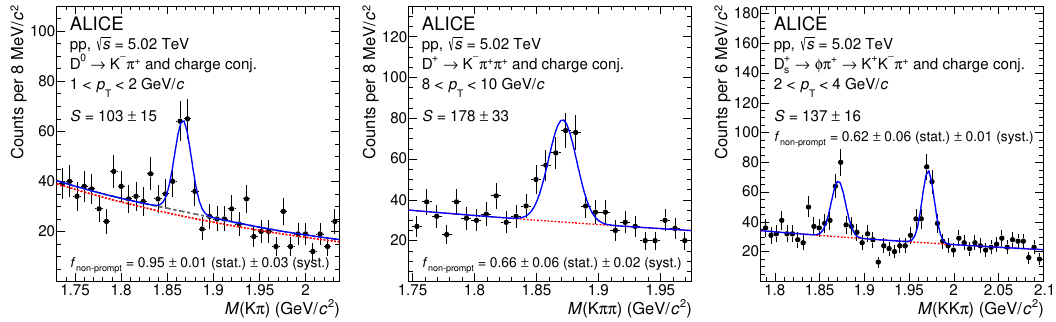
Figure 1 . Invariant-mass distributions of D 0 , D + , and D + candidates and charge conjugates in s 1 < p T < 2 GeV /c , 8 < p T < 10 GeV /c , and 2 < p T < 4 GeV /c intervals, respectively. The blue solid lines show the total fit functions as described in the text and the red dashed lines are the combinatorial background. In case of the D 0 candidates, the grey dashed line represents the combi- natorial background with the contribution of the reflections. The raw-yield ( S ) values are reported together with their statistical uncertainties resulting from the fit. The fraction of non-prompt can- didates in the measured raw yield is reported with its statistical and systematic